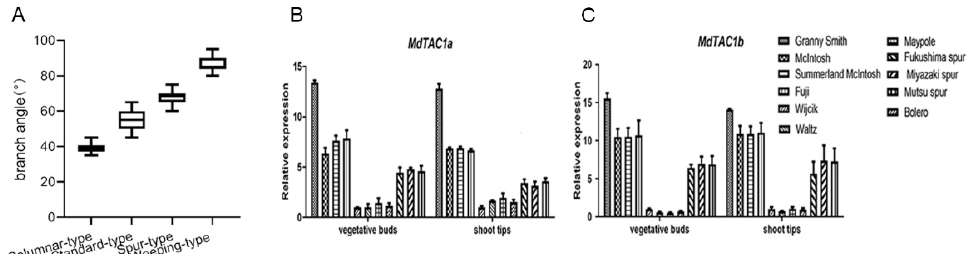
Figure 5. Statistics of branching angles of four tree typesand the expression of MdTAC1a and MdTAC1b in four apple cultivars. ( A ) Statistics of branching angles of four tree types ( B , C ) The relative expression patterns of MdTAC1a/b in vegetative organs of apple